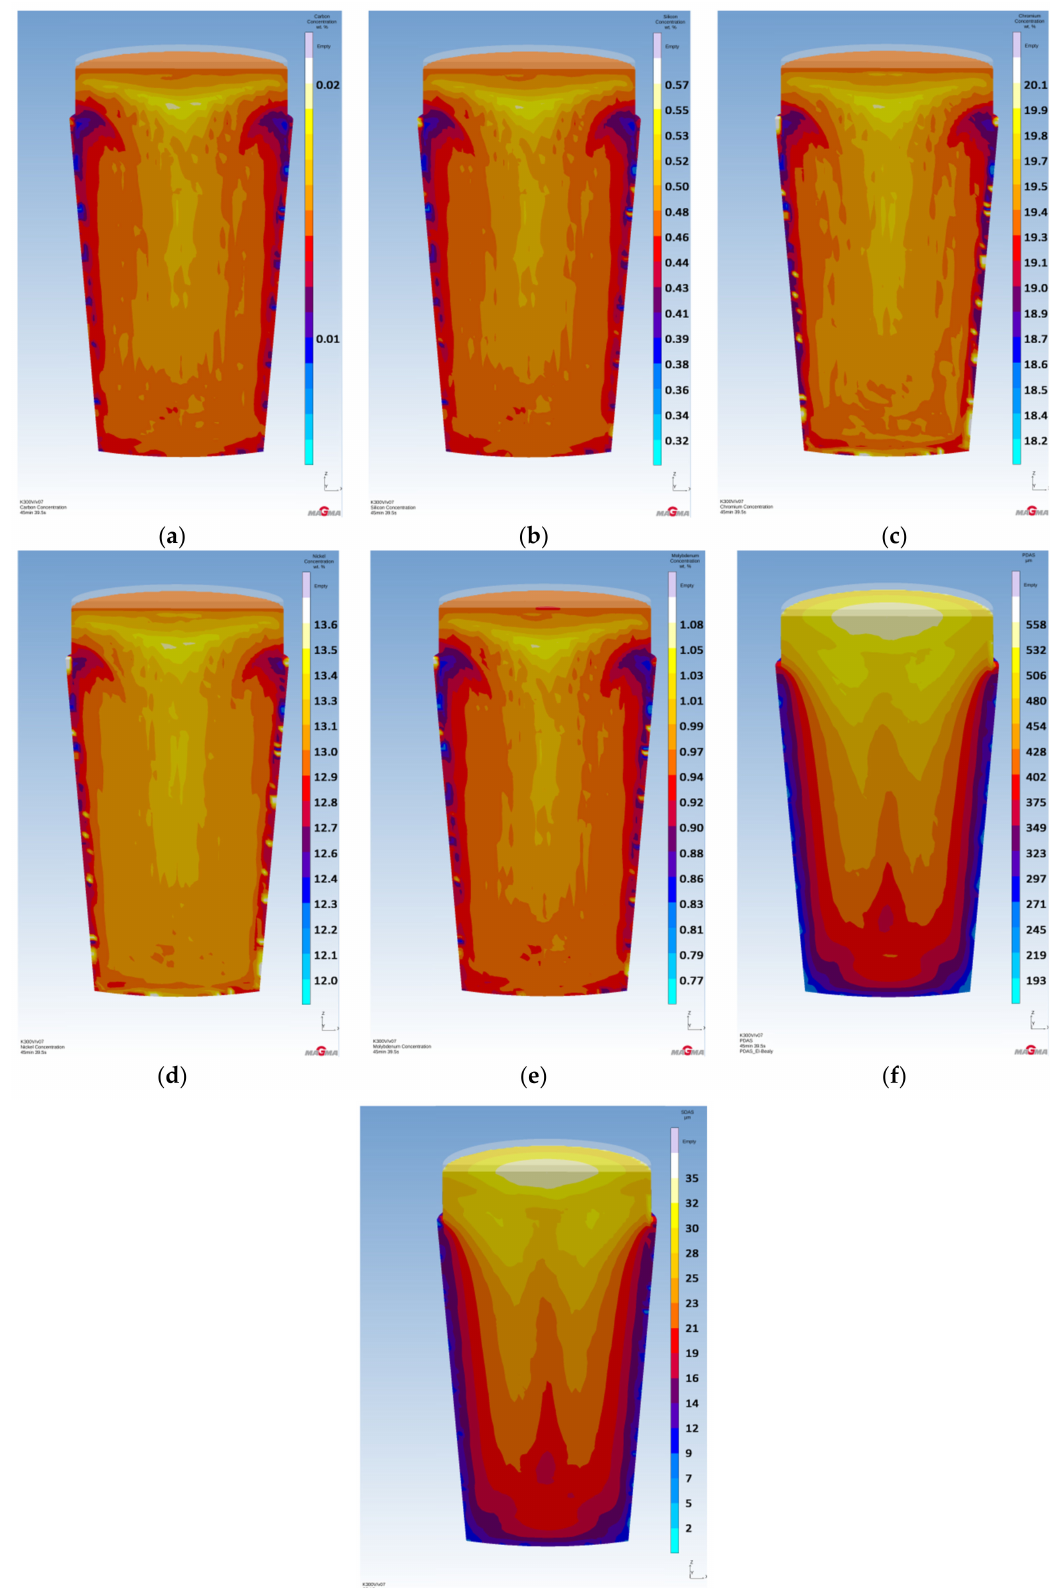
Figure 7. Element segregation, PDAS and SDAS: ( a ) [wt.% C]; ( b ) [wt.% Si]; ( c ) [wt.% Cr]; ( d ) [wt.% Ni]; ( e ) [wt.% Mo]; ( f ) PDAS; ( g )